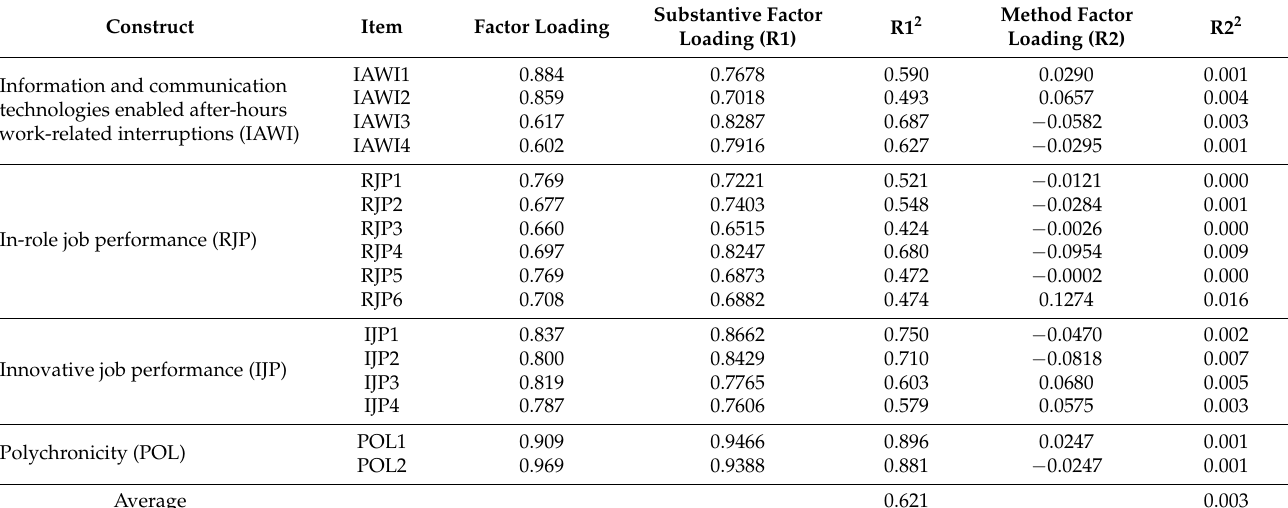
Table 3. Common method bias analysis and factor loadings of measurement items.